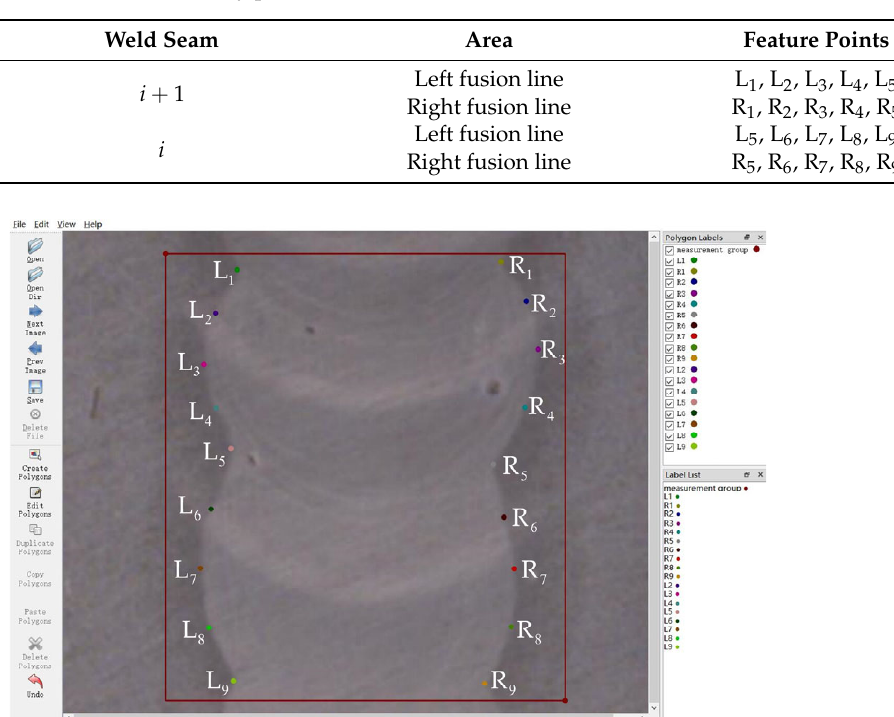
Table 2. Definition of key points of the “Measurement unit”.